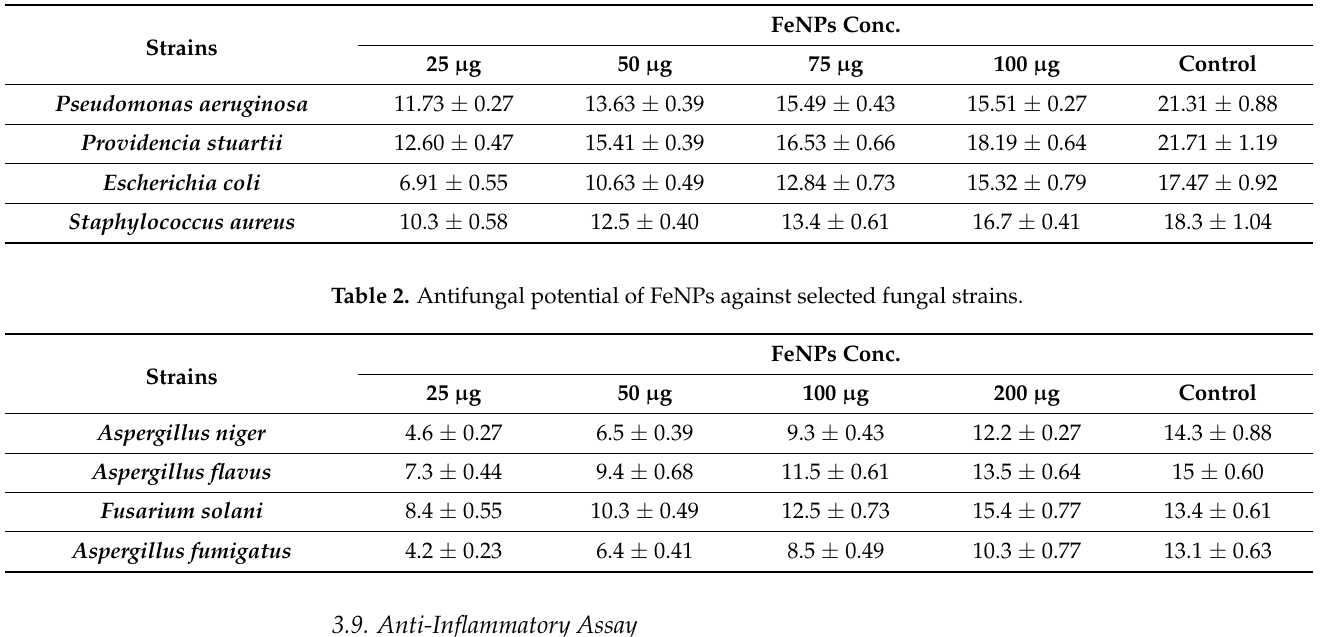
Table 1. Antibacterial potential of FeNPs against selected bacterial strains.